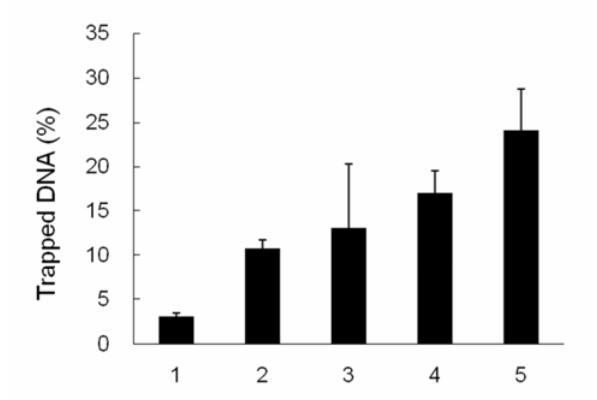
Figure 4: Topoisomerase I (TopI)-DNA complex trapping activity of evodiamine (EVO). 3H-Thymidine-labeled MCF-7 cells were treated with various concentrations (0~30 μ M) of EVO for 60 min. K-SDS precipitation was performed to trap the TopI-DNA complex. Radioactivity counts of trapped DNA were determined using a scintillation counter.